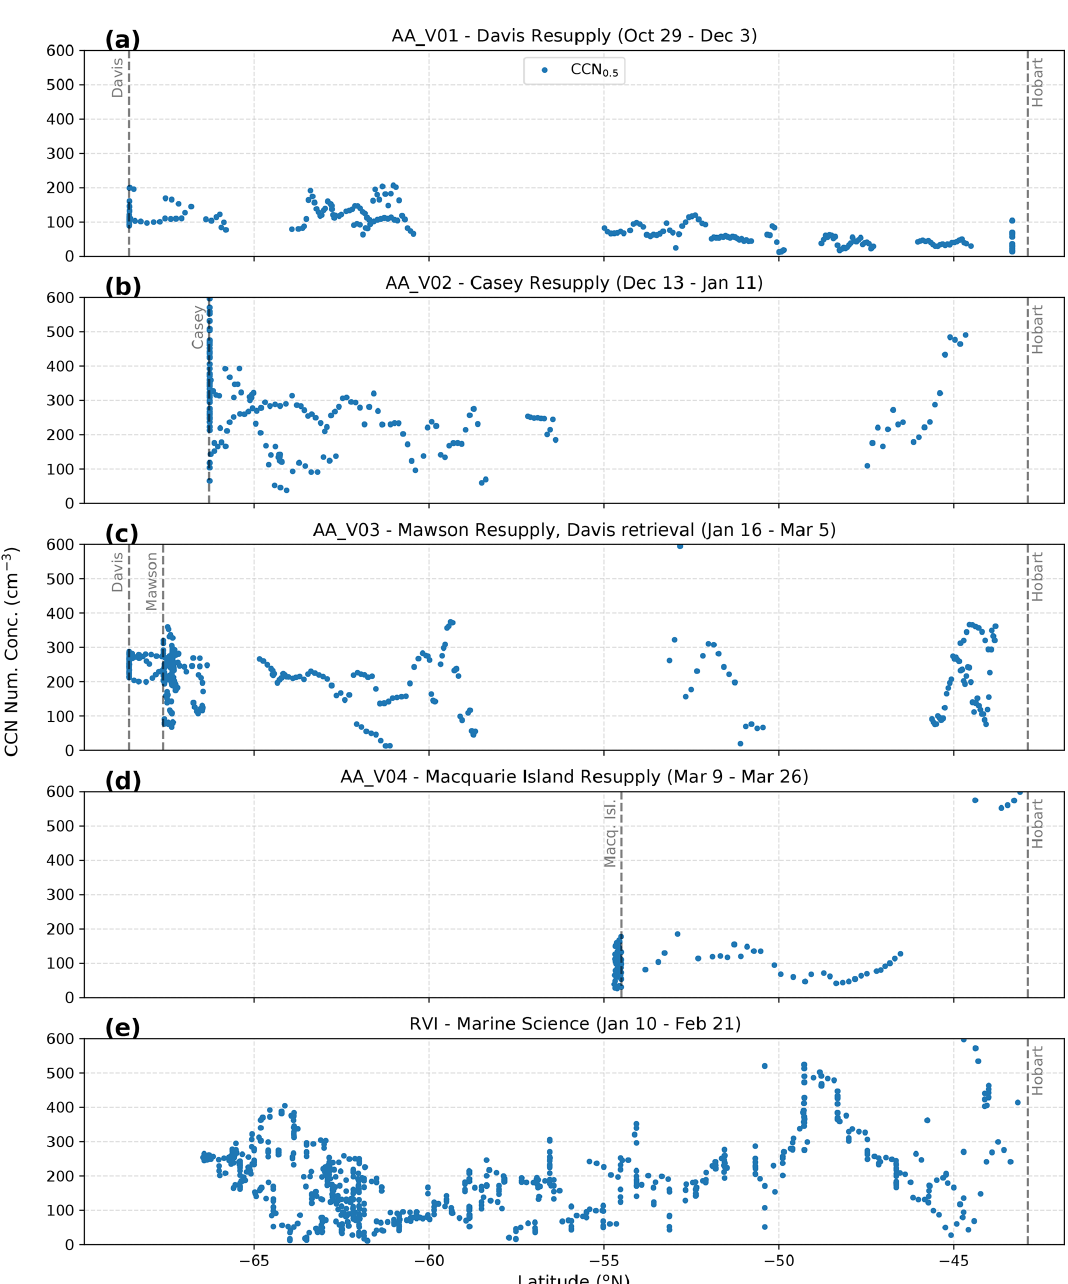
Figure A3. Latitudinal distributions of individual hourly data points for CCN 0 . 5 , split into each of the voyages utilised in this study: (a) MAR- CUS V1, (b) MARCUS V2, (c) MARCUS V3, (d) MARCUS V4 and (e) CAPRICORN2 IN2018_V01. All data are exhaust-filtered.